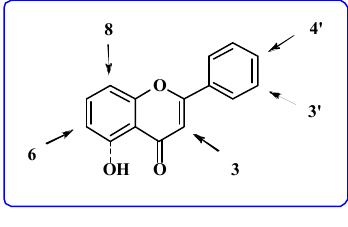
Table 1. The enzyme inhibition of Series I compounds.